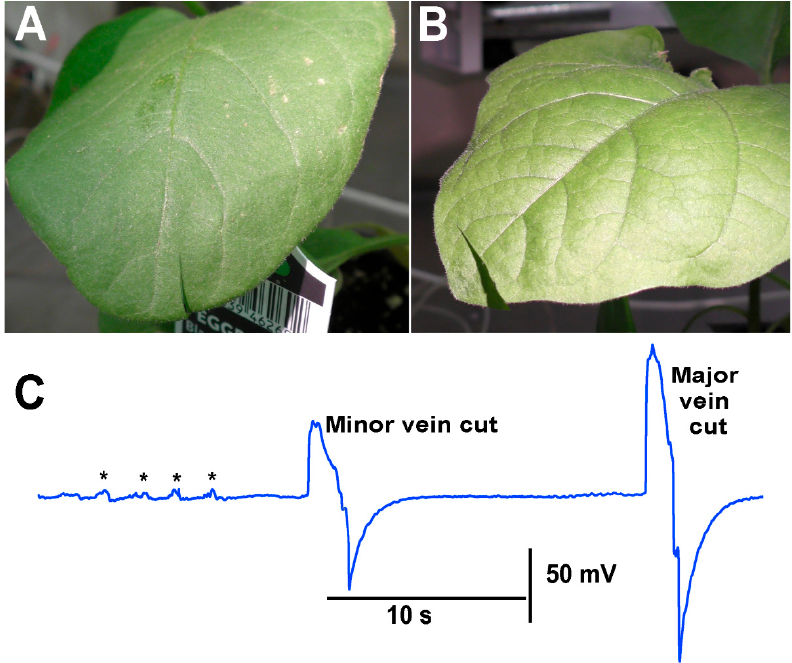
Methods Protoc. 2022 , 5 , x FOR PEER REVIEW12 of 21 Figure 10. Electrical responses when cutting minor veins as compared to a major vein within a leaf Figure 10. Electrical responses when cutting minor veins as compared to a major vein within a leaf of of an eggplant. ( A ) A cut made across a minor vein on a leaf. ( B ) In a leaf on the opposite side of the an eggplant. ( A ) A cut made across a minor vein on a leaf. ( B ) In a leaf on the opposite side of the plant from the leaf shown in A a leaf was cut across the major vein. ( C ) The electrical signal obtained with the impedance measure with leads placed within the stem of an eggplant while making leaf study as it is beyond the scope of this methodological report. Such signals would be of plant from the leaf shown in A a leaf was cut across the major vein. ( C ) The electrical signal obtained cuts. The first cut was from the leaf shown in A and the second cut was made from the leaf shown interest for future studies. with the impedance measure with leads placed within the stem of an eggplant while making leaf in B. The asterisk (*) shown in each recording demarcates a bending of the leaf. cuts. The first cut was from the leaf shown in A and the second cut was made from the leaf shown in To illustrate the usefulness of long term recordings using the impedance method, a B. The asterisk (*) shown in each recording demarcates a bending of the leaf. tomato plant was recorded continuously for 6 h with the impedance lead impaled into the plant. The acquisition rate was at 100 points per second. Thus, rapid changes of a few milliseconds would not be detected. A leaf cut of the same degree but on different leaves at the same height on the plant was performed initially and again after the 6 h of recording for comparisons in responses. (Figure 11). It was interesting to note that over the 6 h recording period some large defections in the recordings were present as well as some oscillations in the wave form (not shown). These oscillations were not analyzed for this